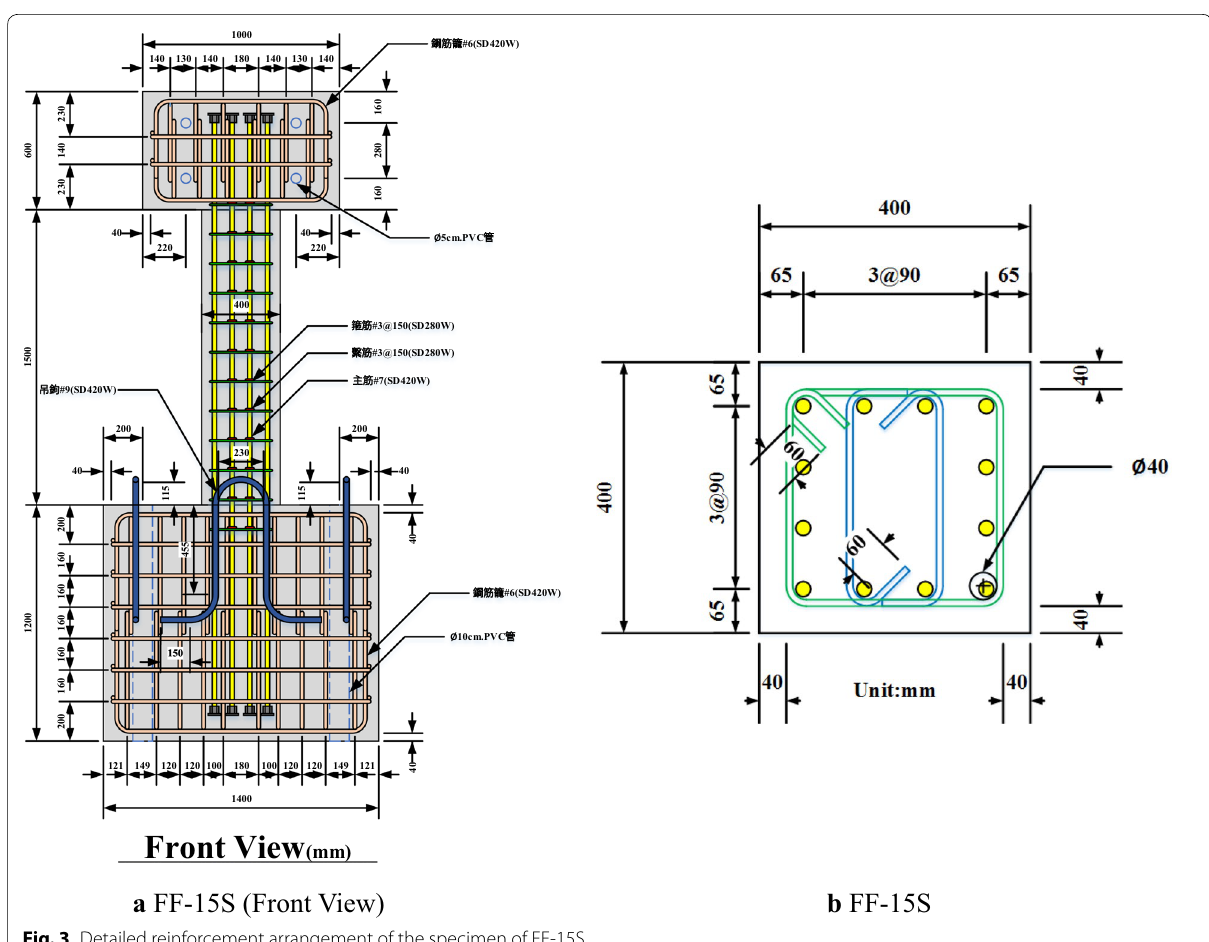
Fig. 3 Detailed reinforcement arrangement of the specimen of